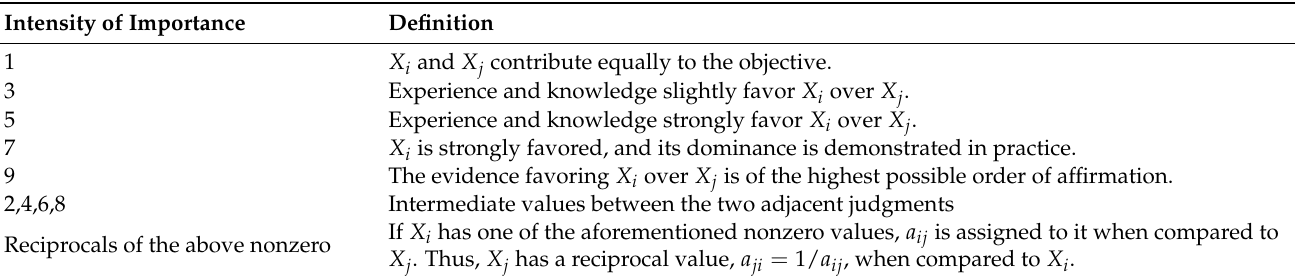
Table 2. Measurement scales of importance intensity and their descriptions.